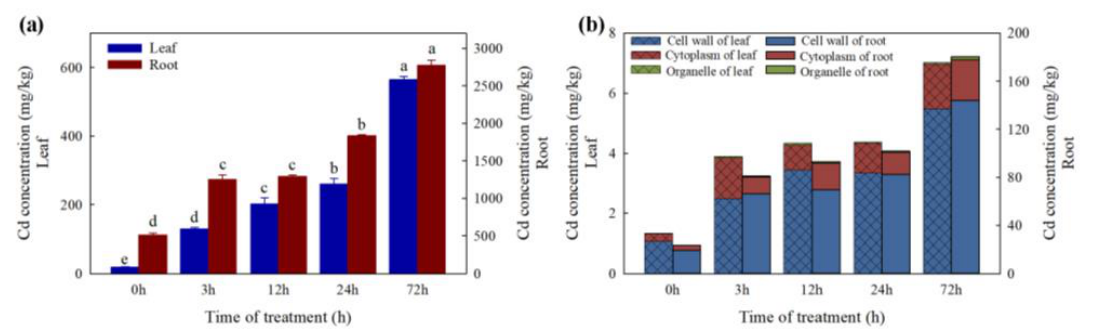
(0.6 – 1.8%) distributed in organelles in T. repens (Figure 2b).